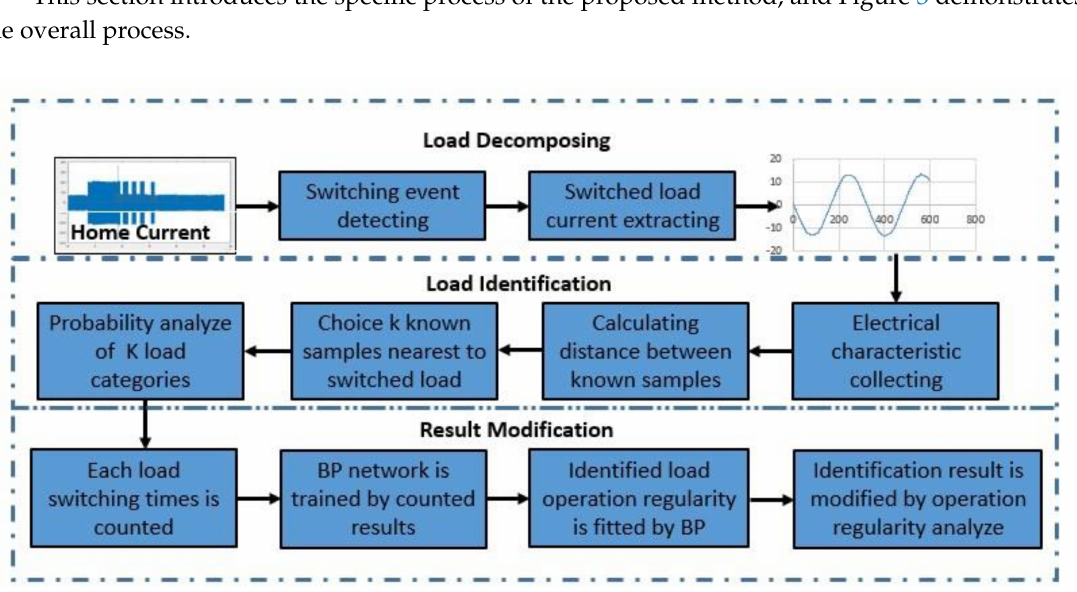
Figure 3. Process of the NILM method. BP: back